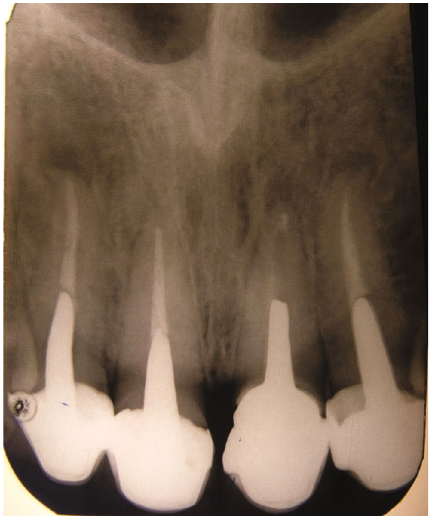
Figure 14: Radiographic view of patient ’ s